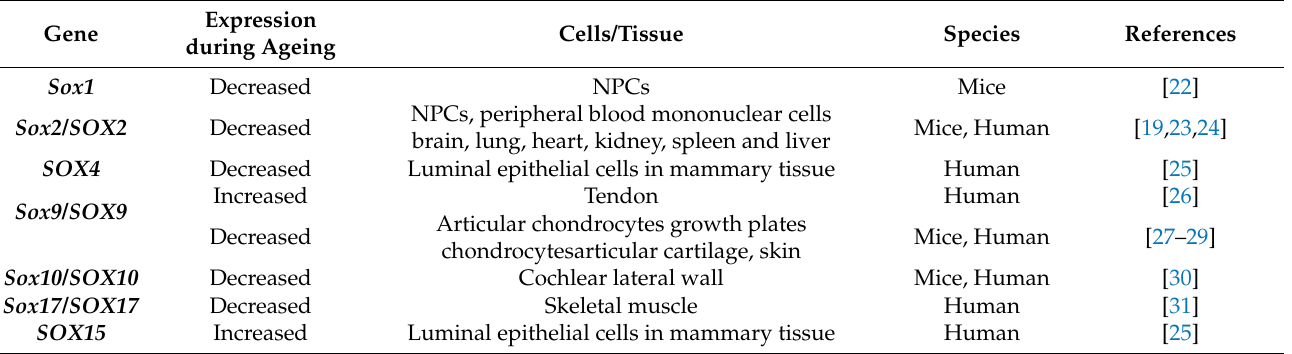
Table 1. Altered expression of Sox / SOX genes during